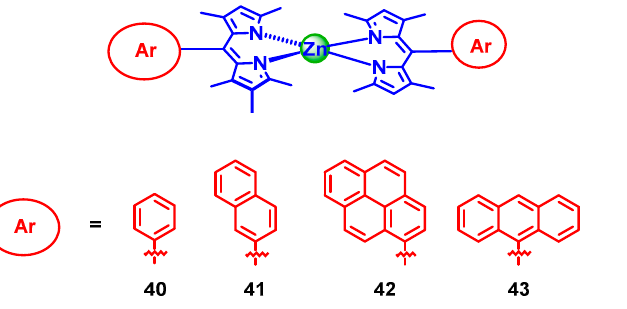
Figure 13. Molecular structures of homoleptic Zn(II) complexes with different substituents.